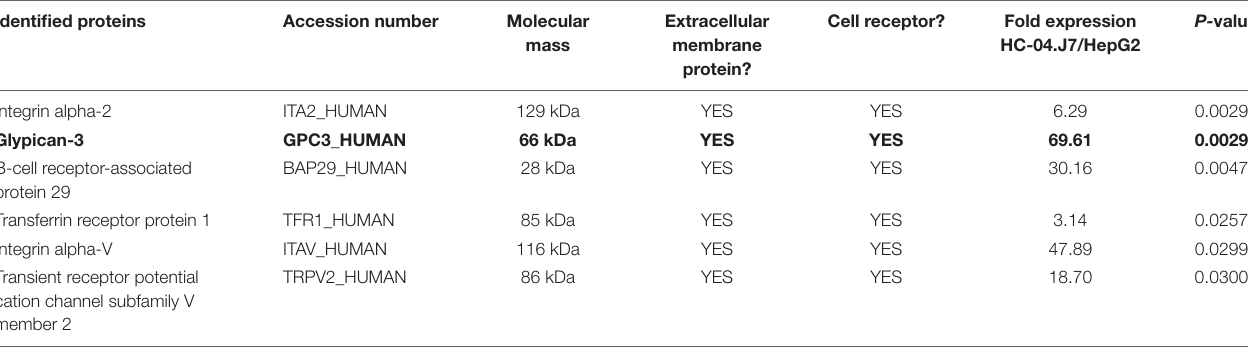
TABLE 3 | Proteins enriched in HC-04.J7 compared to